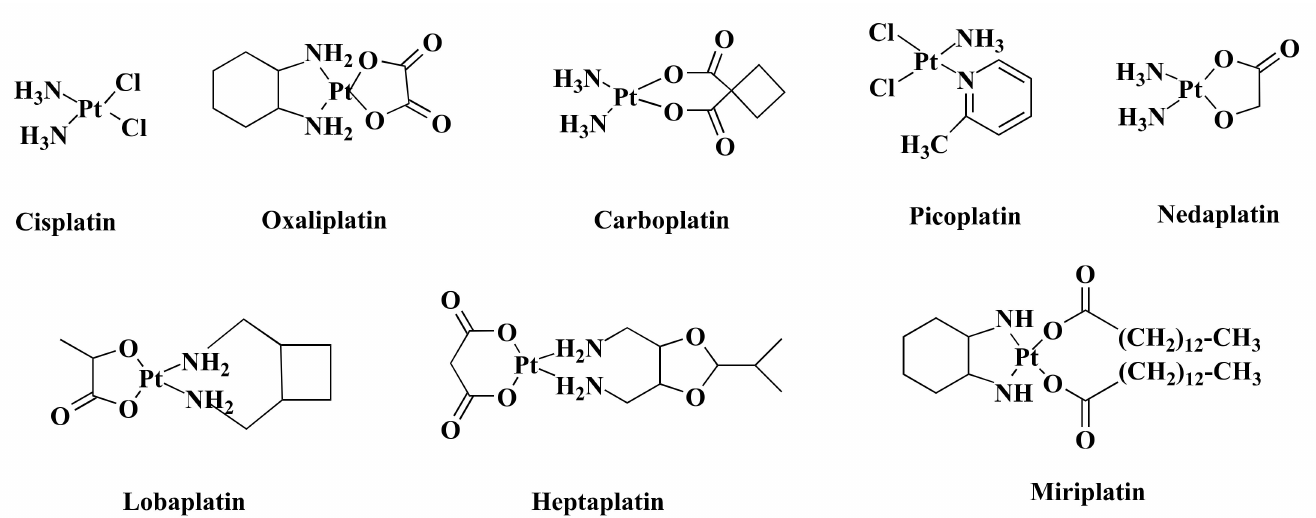
Figure 1. Chemical structure of some Pt-based drugs. Cisplatin, Oxaliplatin, Carboplatin, and Picoplatin have been used worldwide in cancer treatment. Besides, Nedaplatin, Lobaplatin, Heptaplatin, and Miriplatin have been using regionally. Among the Pt-based drugs, only Oxaliplatin is approved by FDA in CRC